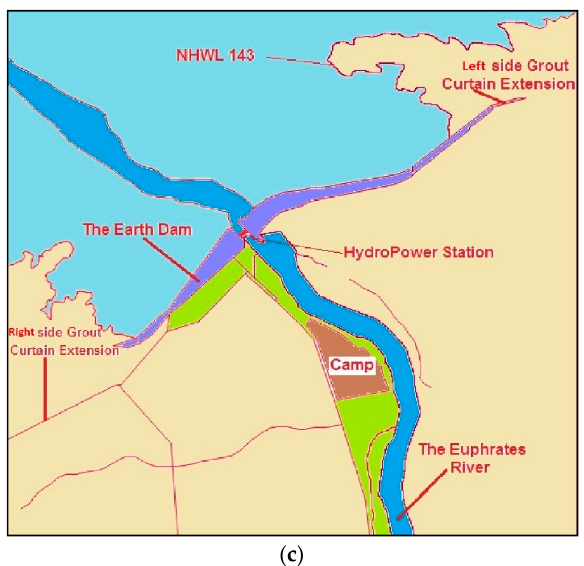
Figure 1. ( a ) Location map of Haditha dam on the Euphrates river, ( b ) Haditha dam coordinates, and ( c ) Haditha dam layout.